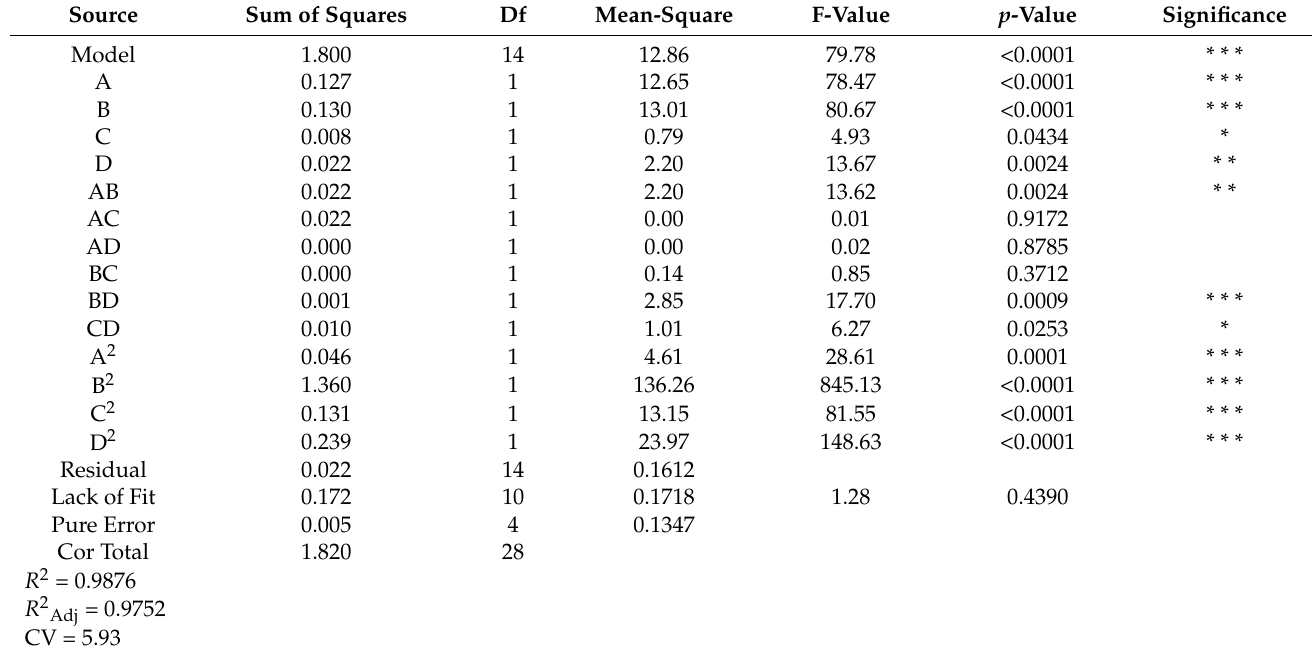
Table 2. Results of response surface regression